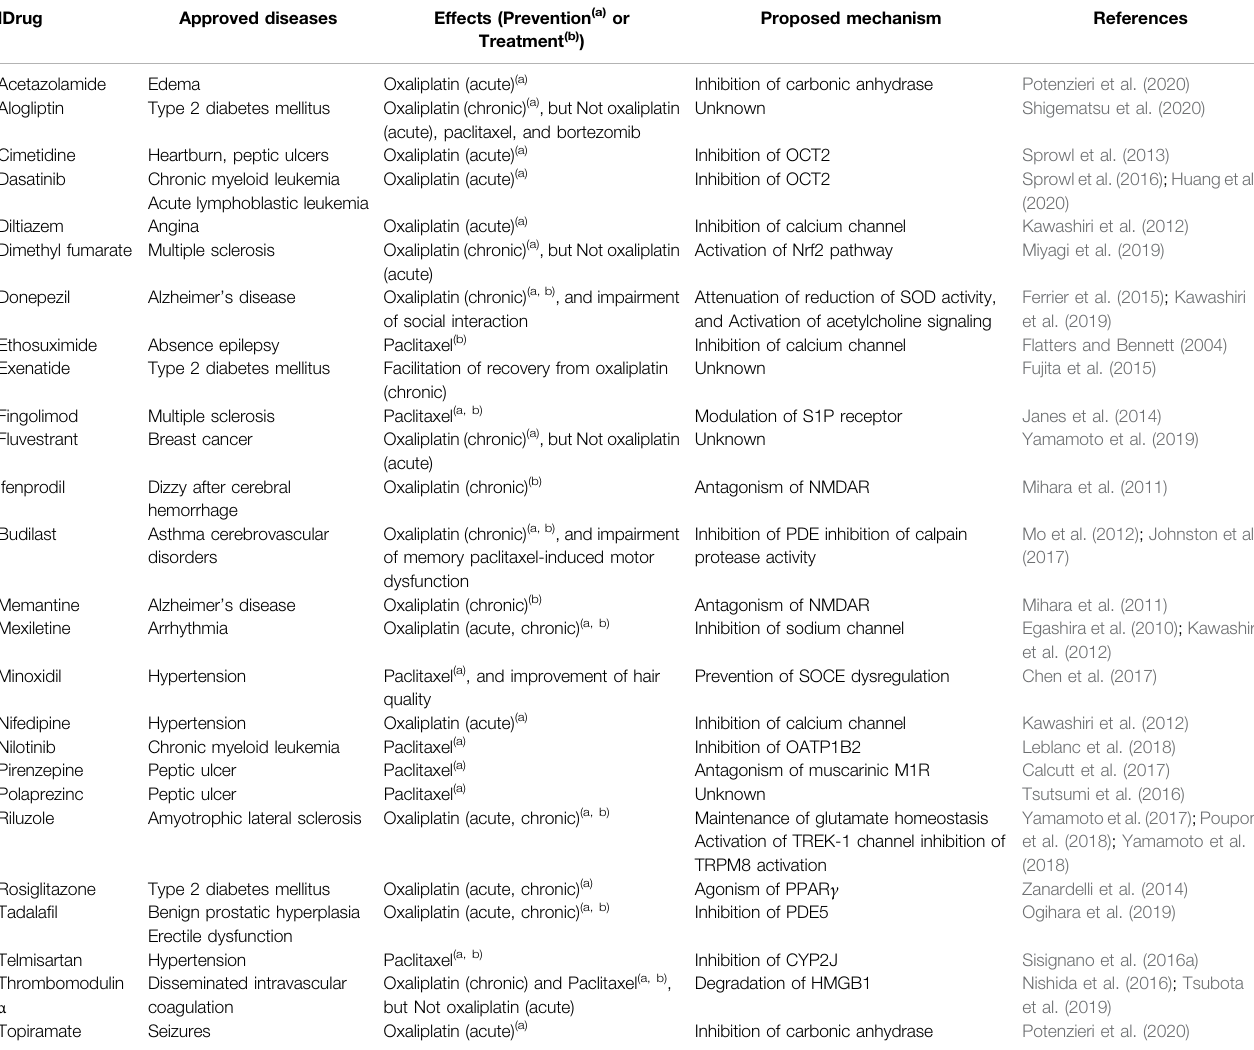
TABLE 1 | Potential candidates of drug repositioning for CIPN identi fi ed in preclinical studies Cytochrome-P 450 -epoxygenase 2J (CYP2J), High-mobility group box 1 (HMGB1), N -methyl-d-aspartate receptor (NMDAR), nuclear factor-erythroid-2-related factor 2 (Nrf2), organic anion-transporting polypeptide B2 (OATP1B2), organic cation transporter 2 (OCT2), phosphodiesterase (PDE), peroxisome proliferator-activated receptor gamma (PPAR γ ), sphingosine 1-phosphate (S1P), store-operated calcium entry (SOCE), superoxide dismutase (SOD), potassium channel subfamily K member 2 (TREK1), transient receptor potential channel melastatin 8